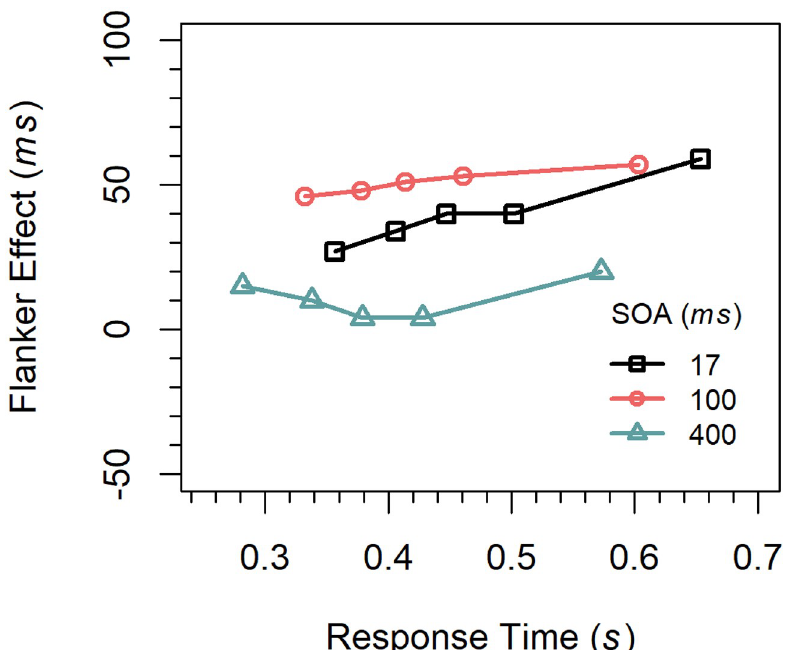
Fig 2. Delta functions for the different conditions in Experiment